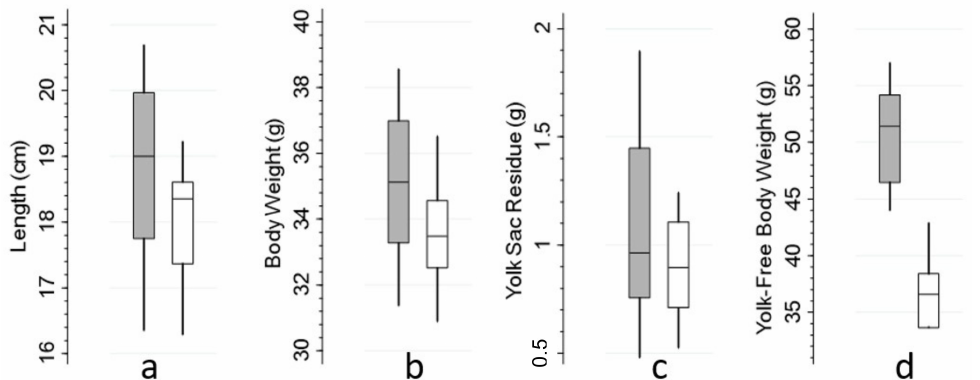
Figure 1. Distribution of the means of quality parameters at the batch level by source (imported in gray and local in white). Each box represents the interquartile range, including the median line. Whiskers represent the lowest and highest adjacent values (the most extreme values within 1.5 interquartile range of the nearer